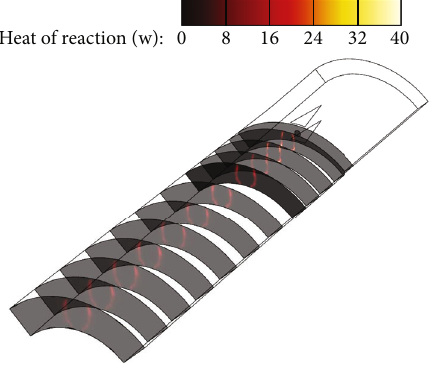
Figure 24: Distribution of combustion heat release rate.